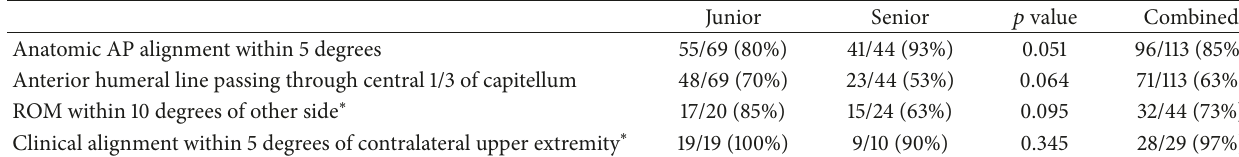
Table 2: Summary of clinical and radiographic outcomes based on